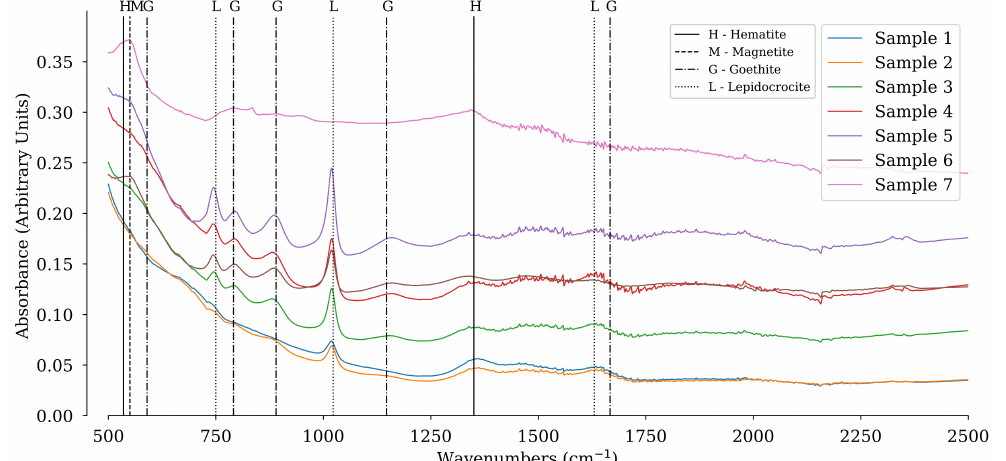
Figure 4. FTIR spectra of all samples. The characteristic wavenumbers for each corrosion mineral are indicated by vertical lines, with an abbreviation for each mineral above the vertical line. The colored lines represent the spectra of the different samples.